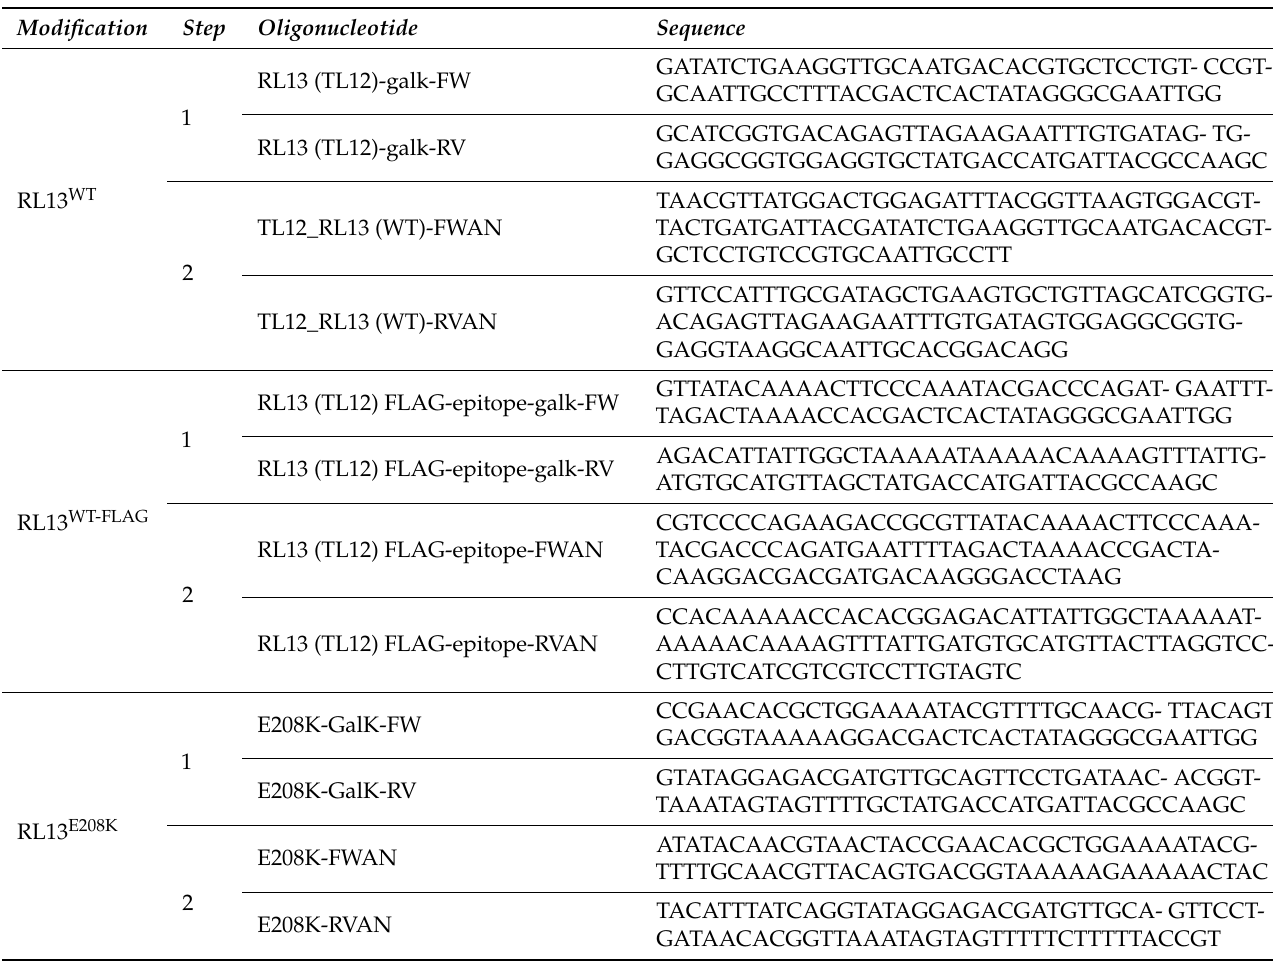
Table 1. Oligonucleotides used for BAC